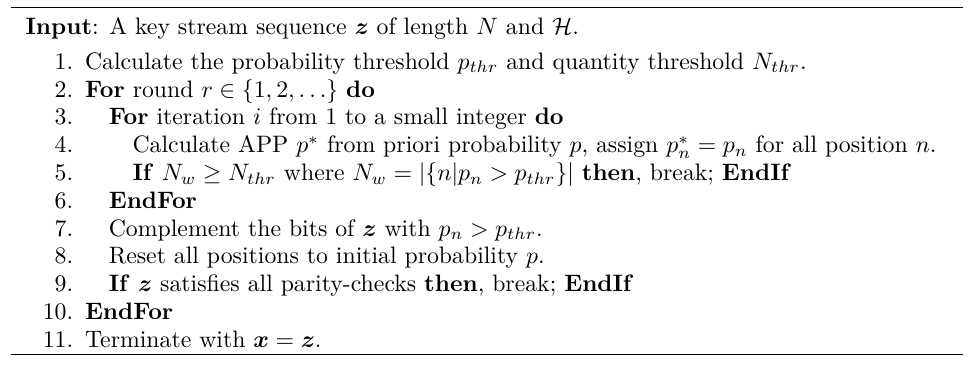
Algorithm 1 Meier and Staffelbach’s binary iterative decoding Algorithm